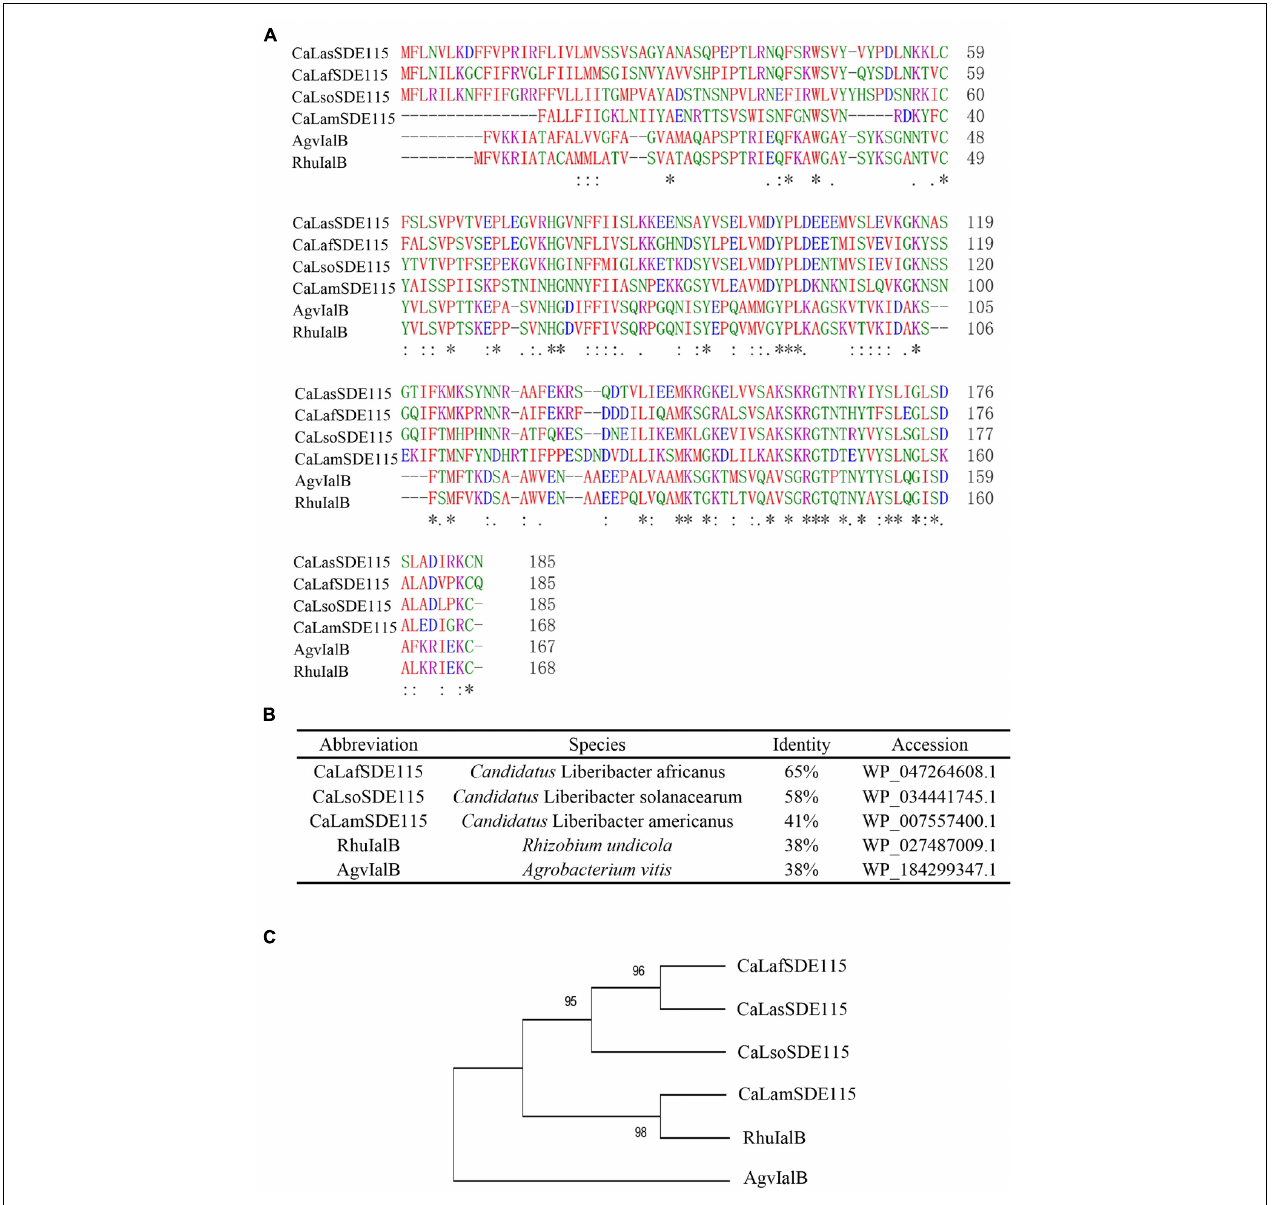
FIGURE 1 | Analysis of Ca LasSDE115 protein sequence. (A,B) Multiple sequence alignment of Ca LasSDE115 with selected homologs. (C) A phylogenetic tree containing Ca LasSDE115 and other selected homologs. The reliability of the tree was estimated using 1000 bootstrap replicates and the bootstrap values (%) are shown above branches. In (A) , “*”, “:” and “.” indicate a single completely conservative, highly and low similar among residues,